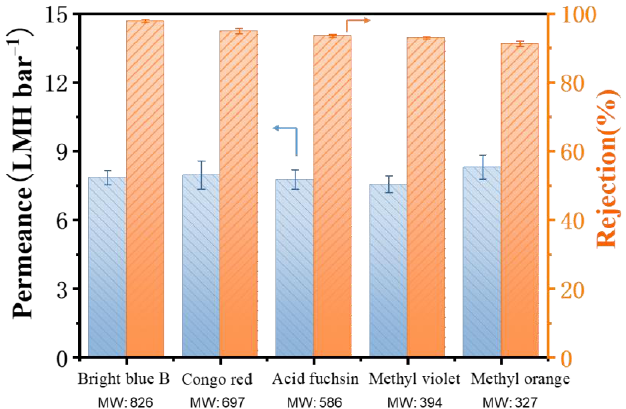
Figure 8. The permeance and rejection of the TFC PA-3 OSN membrane with various dyes/methanol solutions (one membrane for every single data point and the arrow points to the corresponding Y-